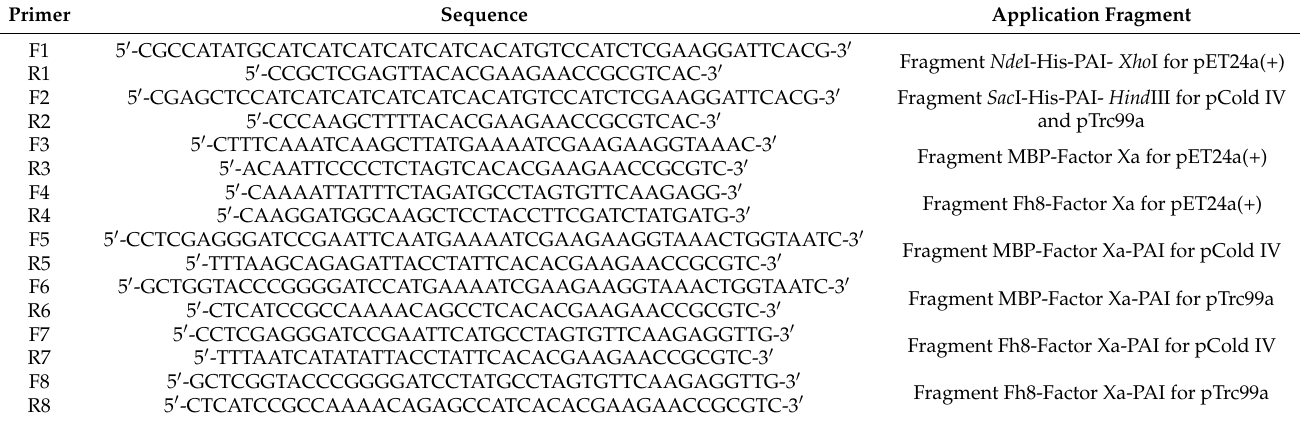
Table 1. Primers used for vector cloning. Underlined nucleotides refer to restriction sites or overlaps.